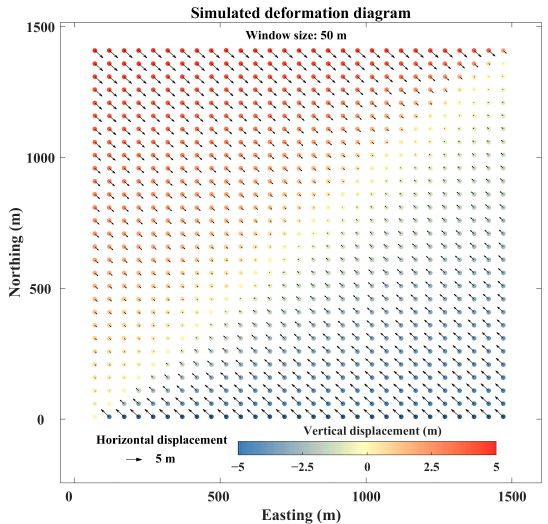
Figure 3. Simulated deformation diagram.